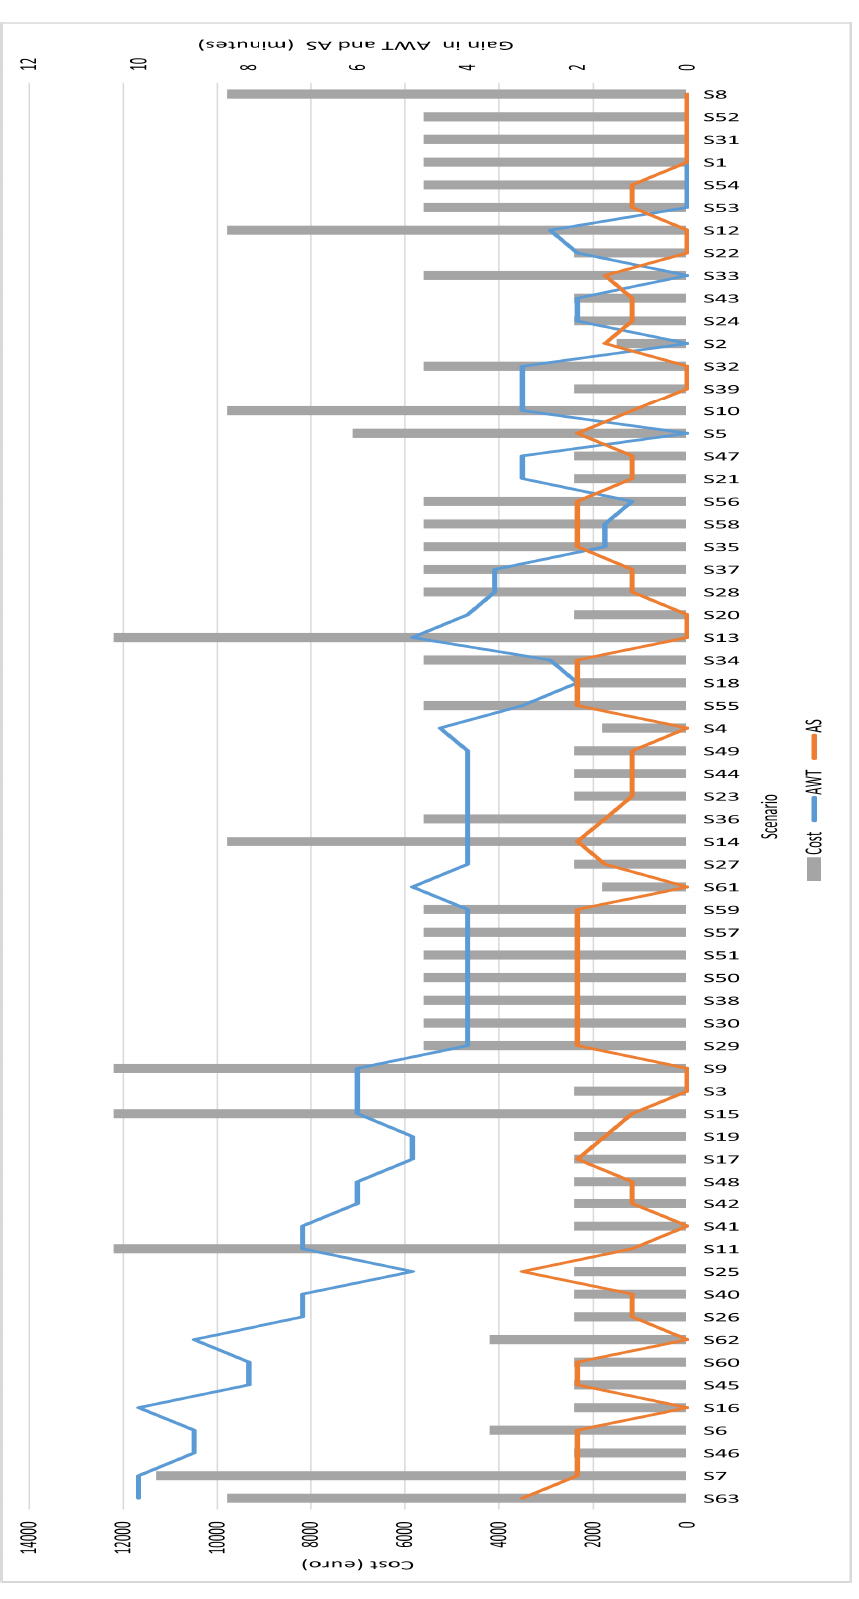
Figure 7. Result of the classification of the scenarios for Category 1 (resource-related—flexible staff and shifts, long